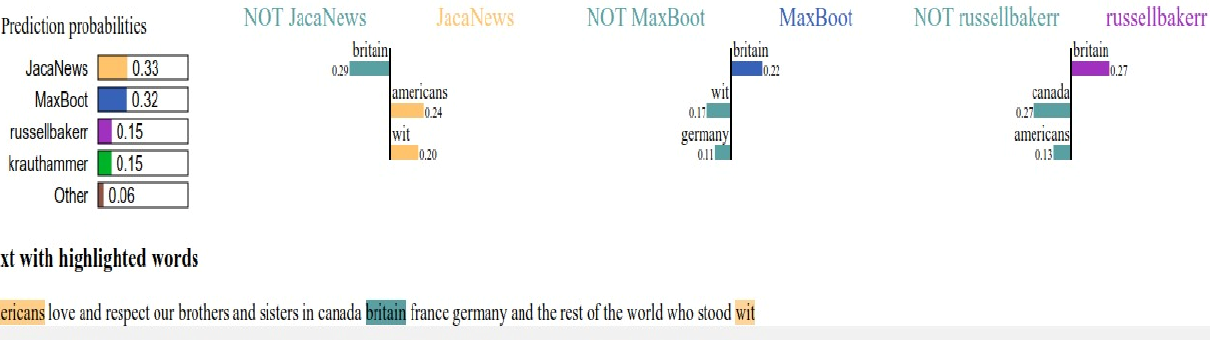
Figure 9. Explanation of individual prediction of the proposed method on the Twitter50 document using LIME.